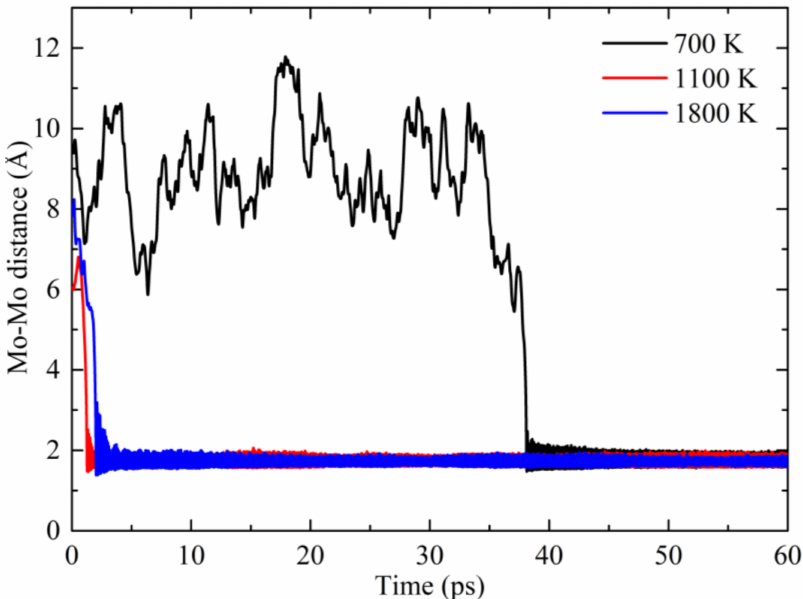
Figure 4. Mo-Mo distance evolution for two Mo atoms in the liquid Na system at different